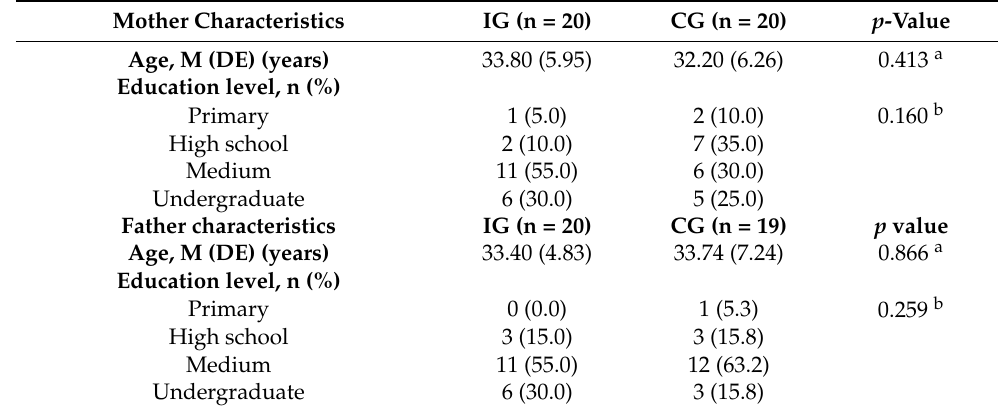
Table 2. Sociodemographic and baseline characteristics of the mothers and fathers of the intervention group (IG) and control group